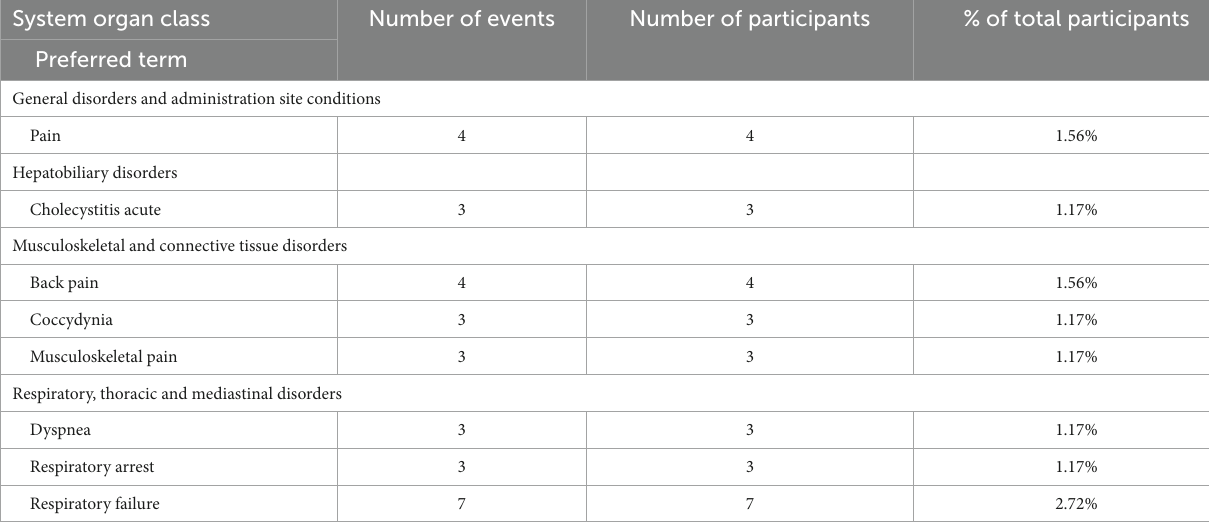
TABLE 4 Summary of serious adverse